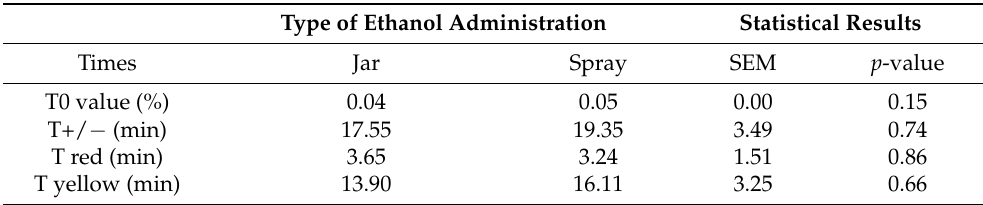
Table 2. Results calculated by the three-way analysis of variance, as the effect of the type of ethanol administration, volume of ethanol used, and time of exposure, expressed as averages with the relative standard error of the mean and p